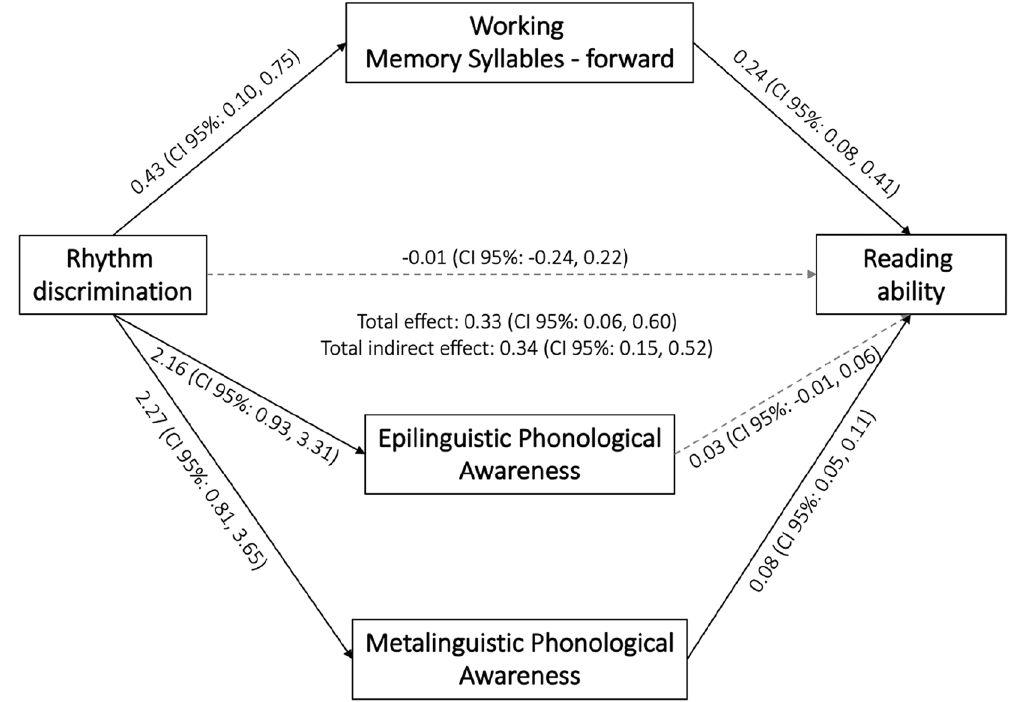
Figure 1. Parallel mediation model (N = 73) depicting the mediation effect of working memory of syllables forward, epilinguistic phonological awareness, and metalinguistic phonological awareness on the association between rhythm discrimination and reading ability. The model was controlled for cognitive ability. Effects were considered significant when the CIs did not include 0. Inference was based on percentile bootstrap 95% confidence intervals (CIs) with 20,000